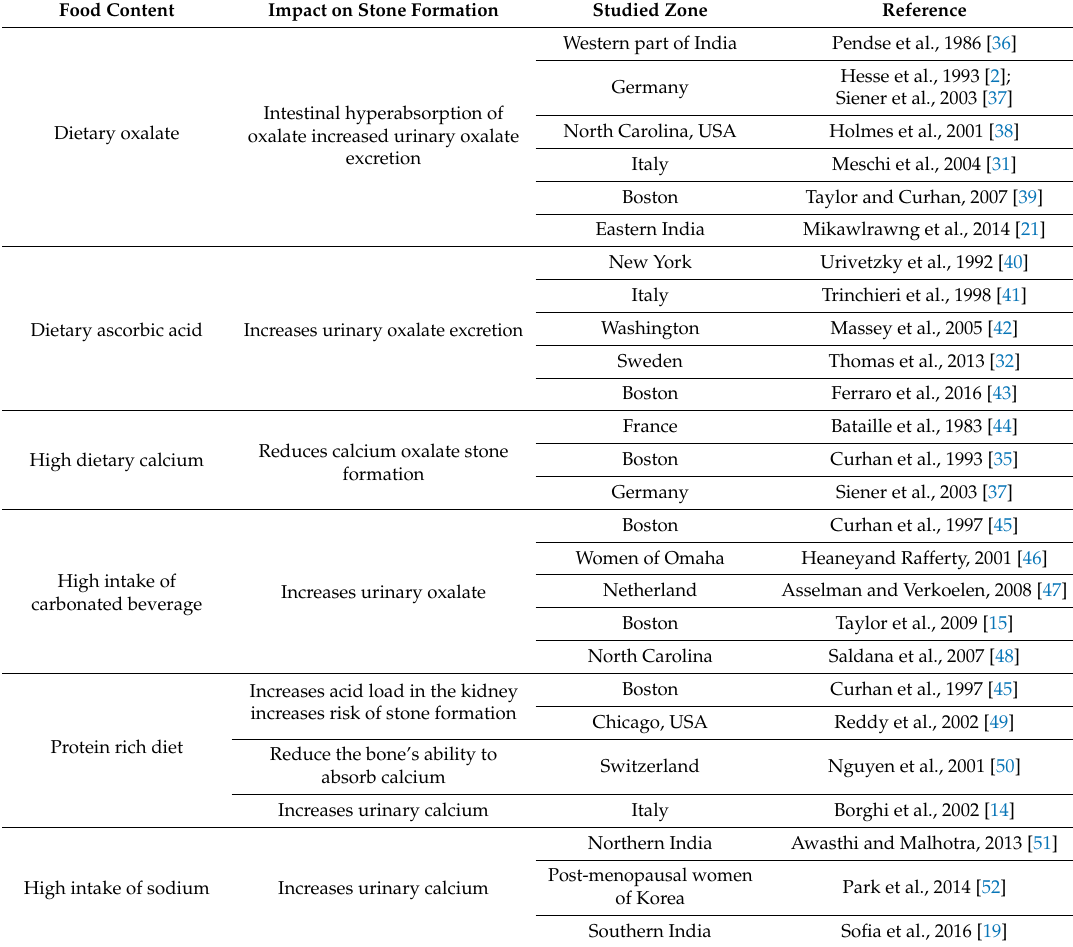
Table 1. Impact of food content and the prevalence of kidney stone diseases (KSD) in some different